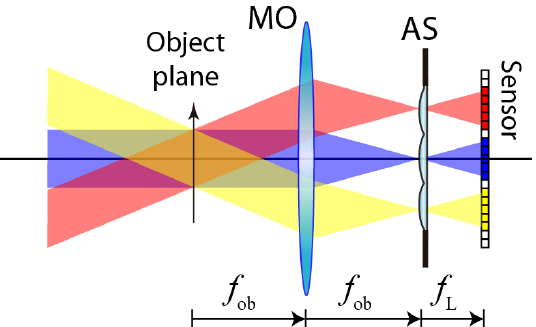
Figure 1. Basic scheme of the Fourier lightfield microscope. The MLA is placed at the aperture stop (AS) of the microscope objective (MO). Note that the object is assumed to be of a 3D nature. Thus, only one section of it (the one placed at the so-called object plane) is conjugated with the